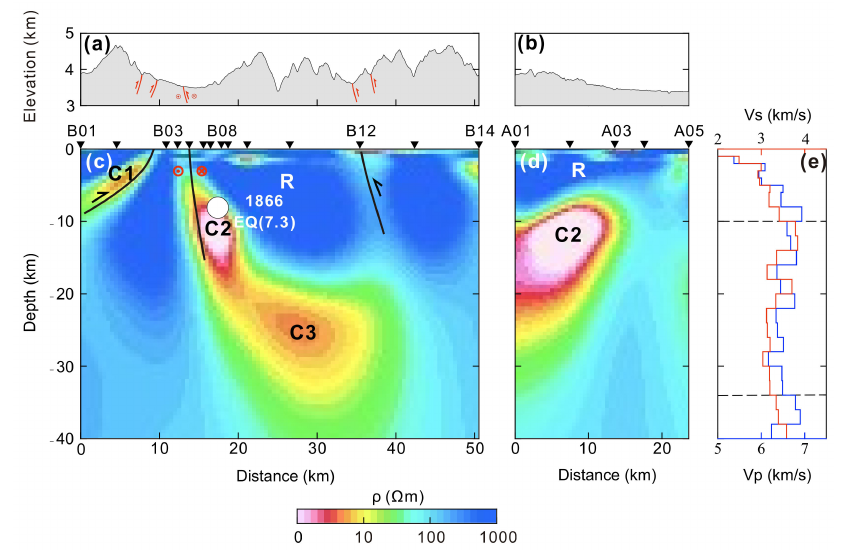
Figure 8. The 3D model displayed with the 10 Ω m isosurface. The yellow isosurface represents the isosurface of 10 Ω m. This model reveals three conductors in the crust (C1–C3). MT sites are indicated as black triangles. High conductors C2 and C3 connect to the lower